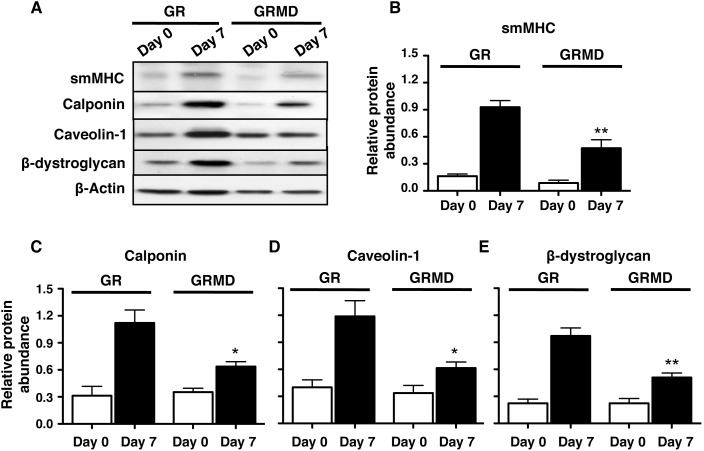
Loss of dystrophin reduces contractile protein markers.For all panels, day 0 represents protein lysates obtained from serum-fed confluent cultures, and day 7 represents protein lysates obtained from confluent primary tracheal smooth muscle cell cultures (obtained from GR and GRMD animals) after 7-day serum deprivation, with medium changed every 48 h. A: representative western blots for various contractile marker proteins under conditions described above. B: densitometry analysis of the effects of serum deprivation on smMHC (B), calponin (C), Caveolin-1 (D) and β-dystroglycan (E) in GR and GRMD tracheal smooth muscle cells are shown. For all histograms protein abundance was corrected for equal loading and normalized relative to β-actin abundance. Data shown represent means ± SE from 6–9 experiments using 3 different primary cells obtained from GR and GRMD animals respectively. Statistical comparisons shown were performed by 1-way ANOVA with Tukey’s multiple comparison tests. *P<0.05, **P<0.01, for GR day 7 versus GRMD day 7.